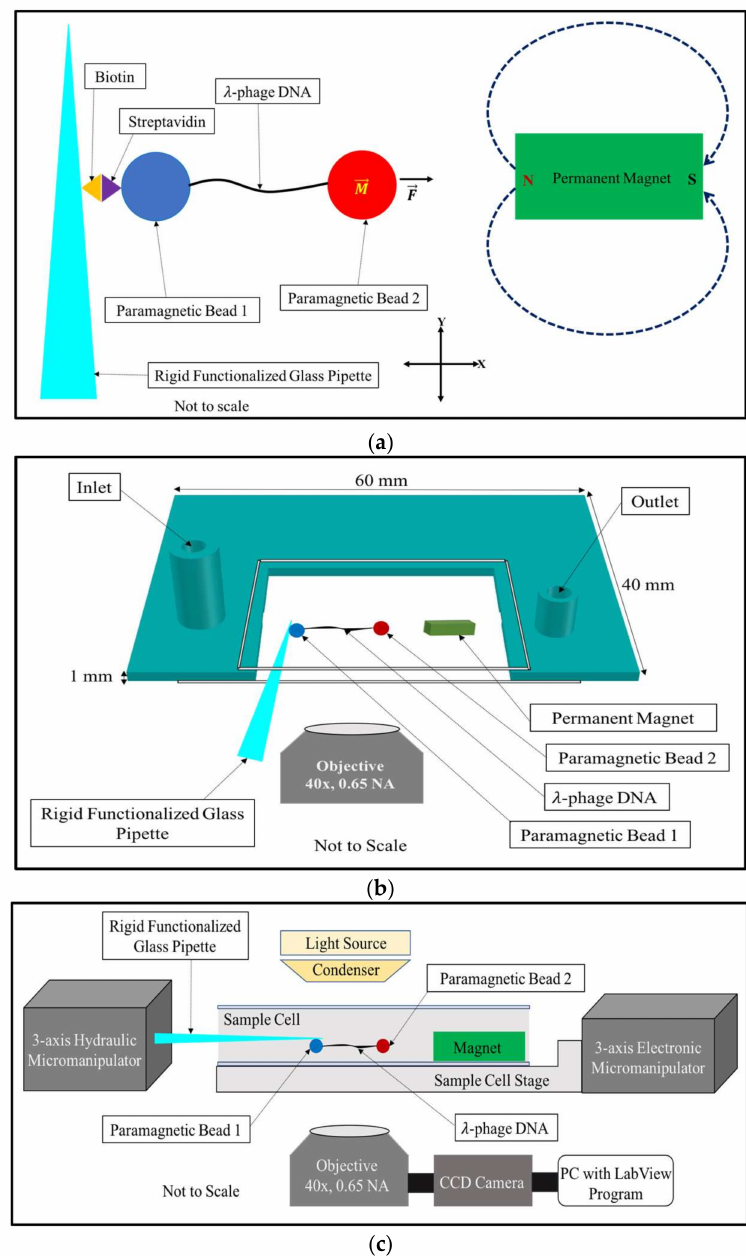
Figure 1. Basic principle of the horizontal magnetic tweezers: ( a ) the tweezers uses a rigid functionalized glass pipette to manipulate a bead attached to one end of a DNA tether and immobilized by biotin-streptavidin interactions to the surface of a rigid glass pipette. The other end of the tether is attached to a superparamagnetic bead suspended in buffer and placed at varying distances from a 3 mm × 2 mm × 1 mm bar magnet. Forces ranging from 0.5 pN to 100 pN (and higher) can be produced by moving the DNA-magnet distance from 2000 µ m to 100 µ m; ( b ) the design of the sample cell is shown. The sample cell has an inlet and an outlet for buffer exchange. The open side of the sample cell allows the insertion of the functionalized glass pipette used to capture and immobilize DNA-bead pairs; ( c ) a block diagram showing the layout of the horizontal magnetic